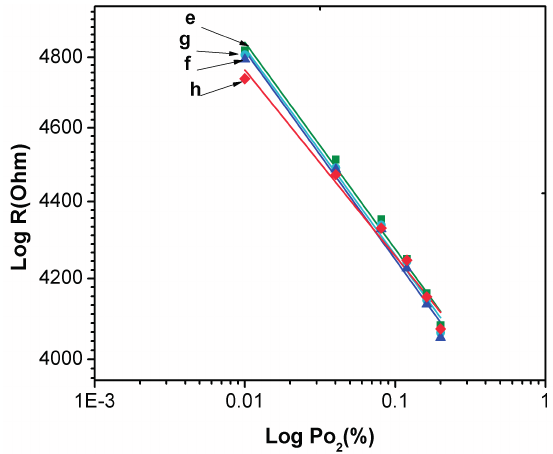
Figure 8. Relationship between the resistance R and the input oxygen partial pressure Po